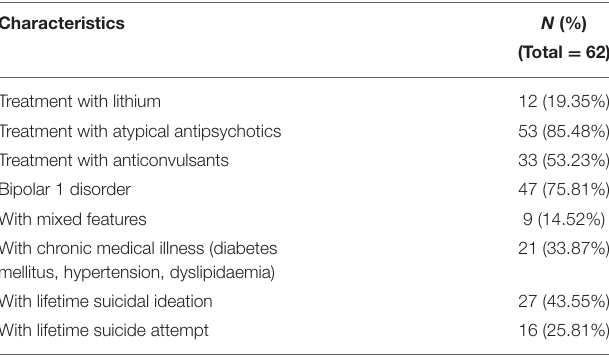
TABLE 1 | Clinical characteristic of BD patients.